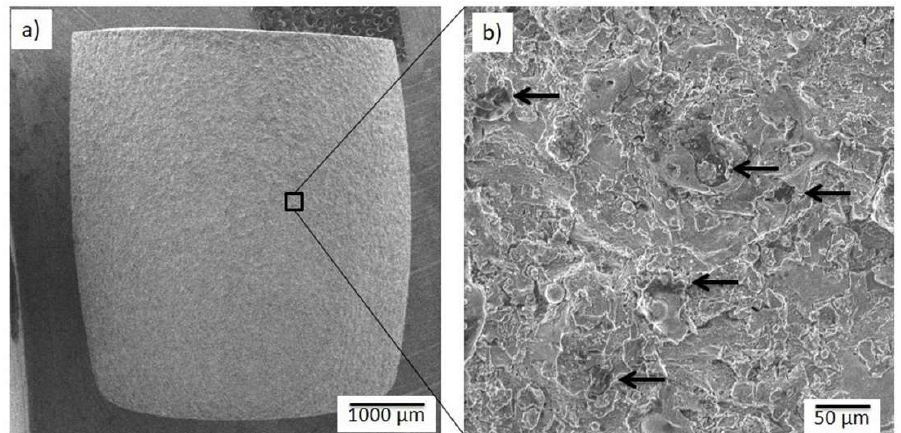
Figure 11. SEM micrograph of hot compressed sample ( a ) Overview of bulged sample ( b ) indication of serrated boundaries.